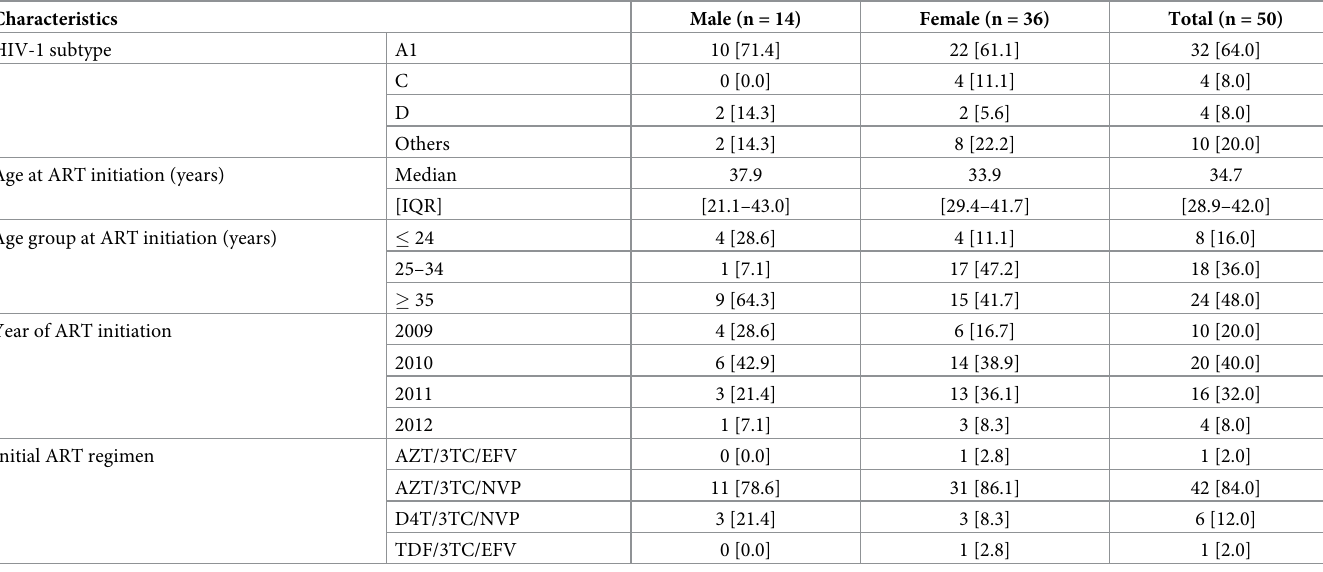
Table 1. Characteristics of individuals enrolled for HIV-1 care and included in the analyses from rural Coastal Kenya (N = 50). Characteristics Male (n =